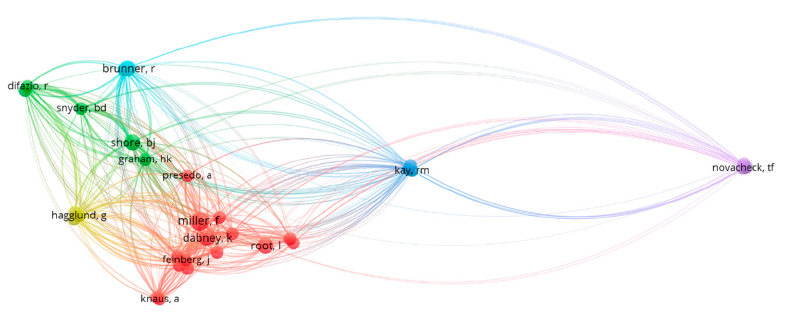
Figure 4. Co-citation by authors.